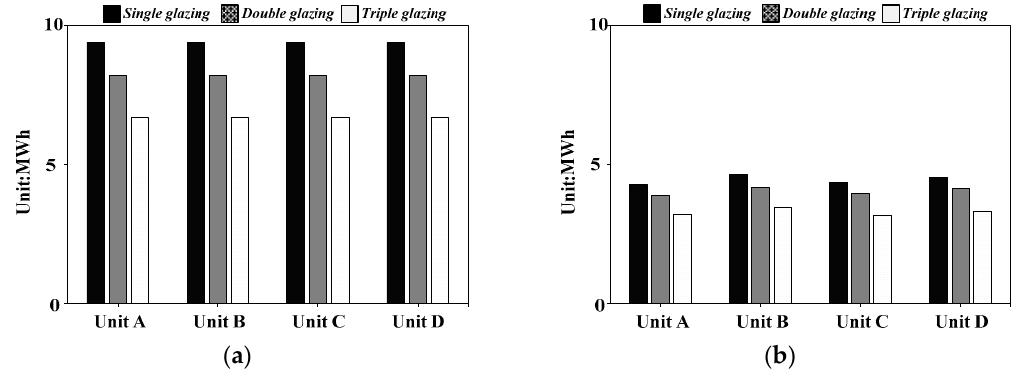
Figure 4. The effect of window glazing on building energy consumptions. ( a ) Heating loads; ( b ) Cooling loads.